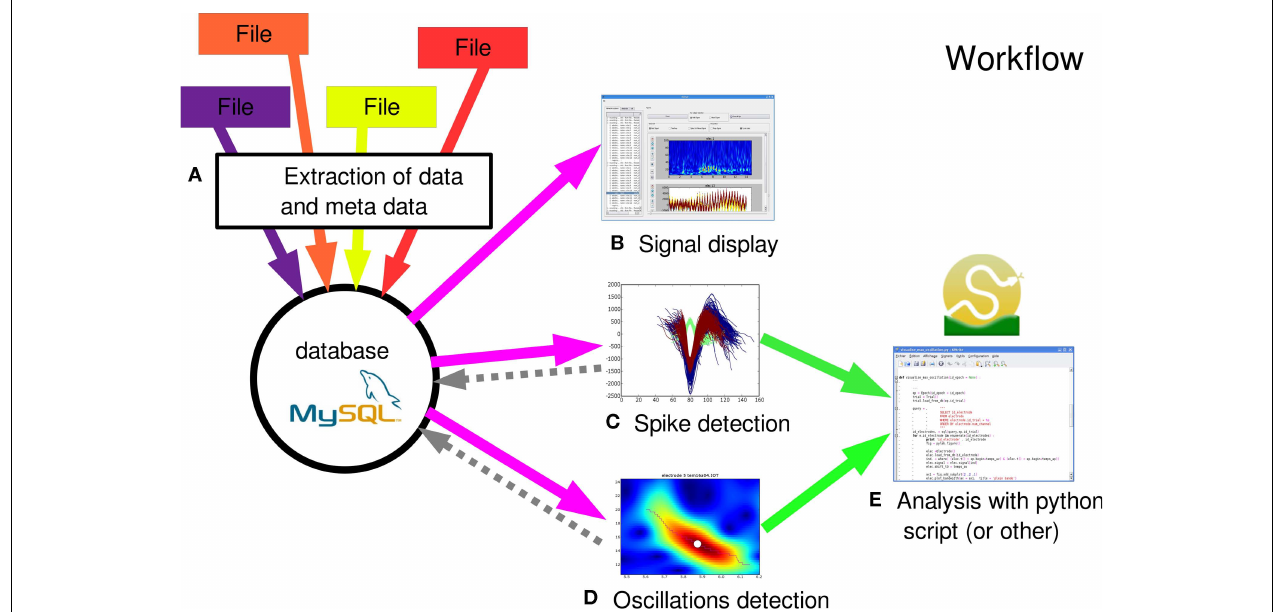
FIGURE 2 | General work fl ow. The main steps for using OpenElectrophy are: (A) integration of data from a heterogeneous collection of fi les into the database; (B) exploration and plotting of raw signals directly from the database; (C) extraction of spikes from the raw signals and integration of